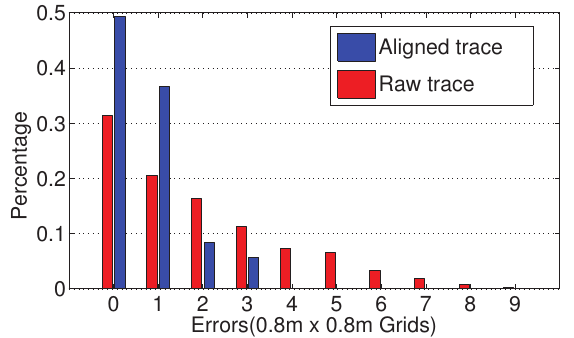
Figure 12. Location deviation of crowdsourced